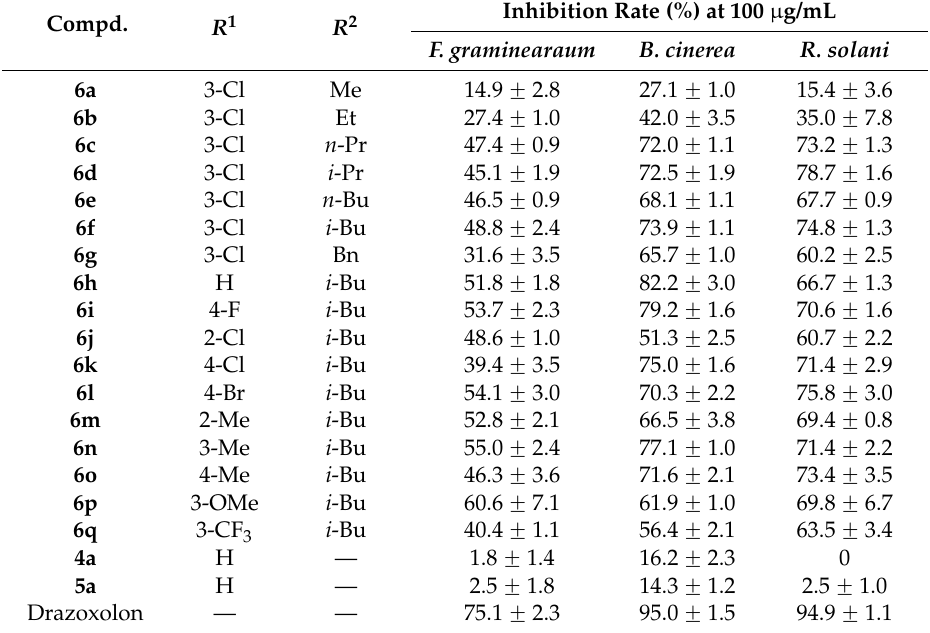
Table 4. Percentage inhibition of compounds 6 , 4a , and 5a against three test